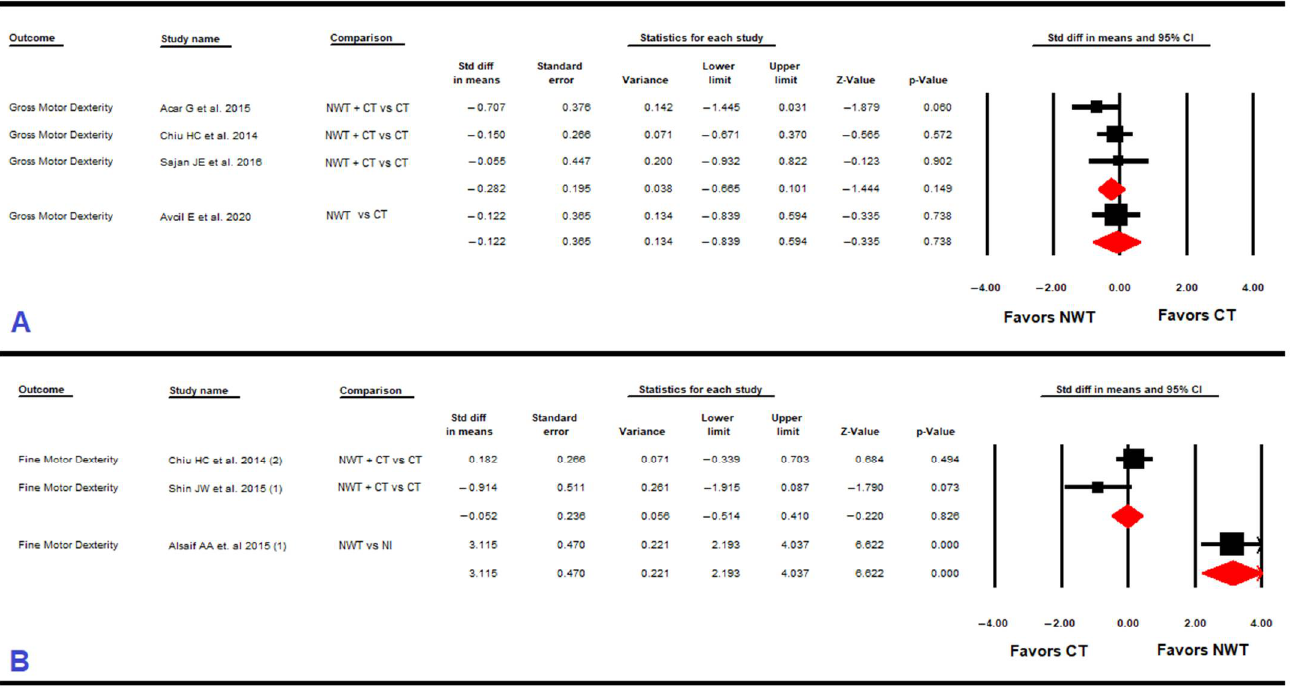
Figure 4. Forest plot effect of Nintendo ® Wii therapy on gross motor dexterity ( A ) and on fine motor dexterity ( B ).